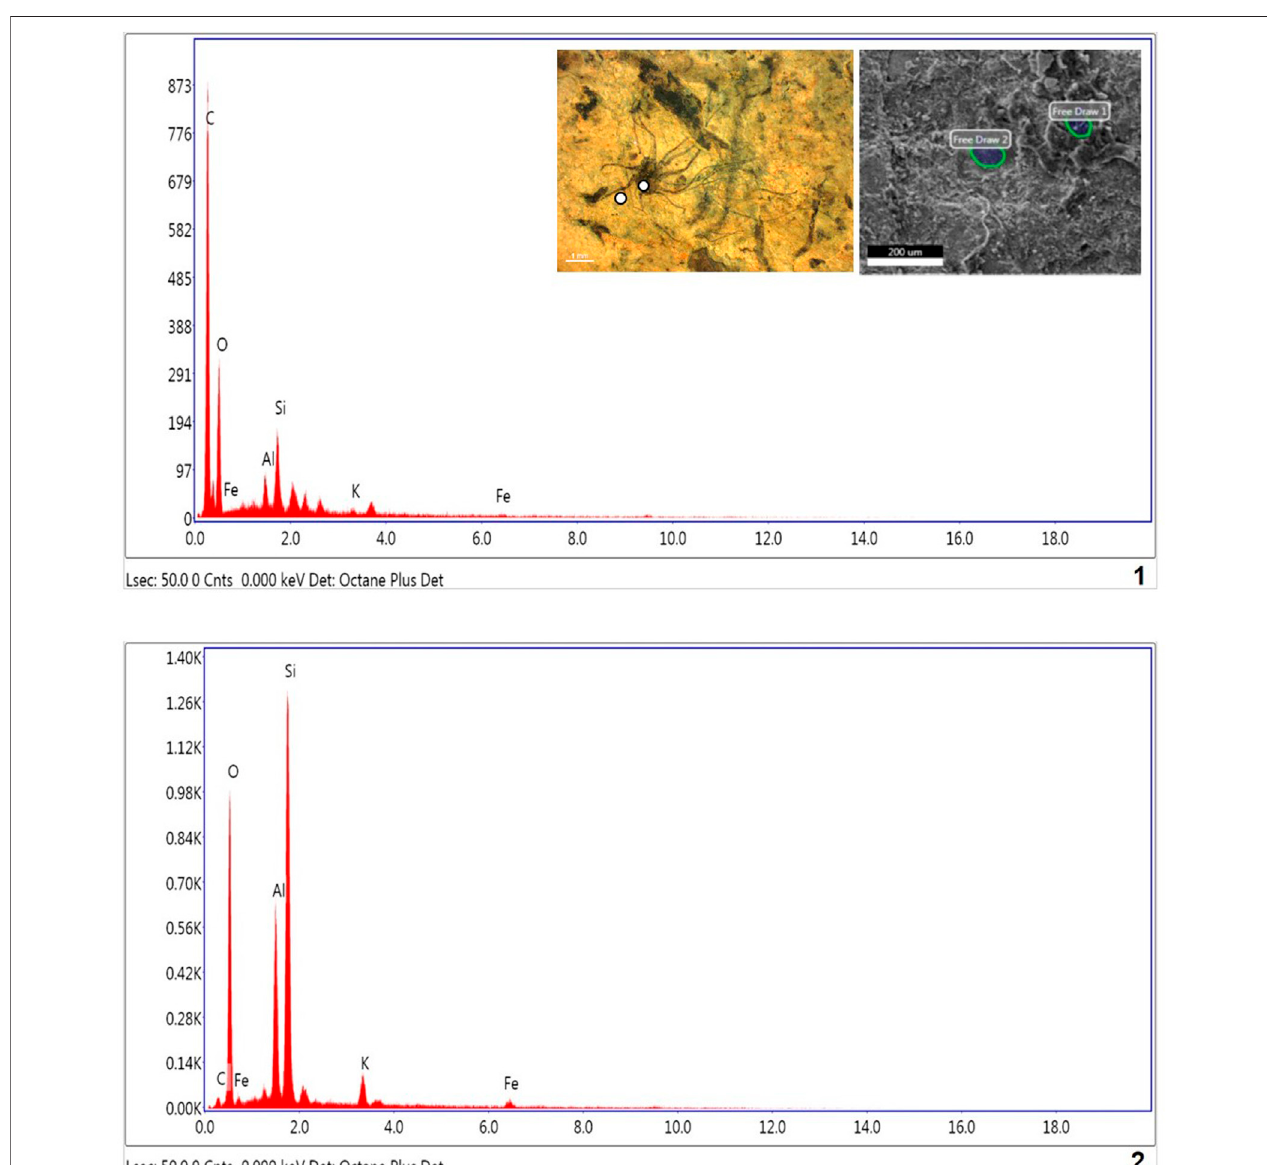
FIGURE 9 | EDX spectra of Singhora carbonaceous compressions and host rock. 1 . Macroscopic fi lm shows high concentration of C and low concentration of other elements respectively. Presence of high carbon in fossils indicated carbonaceous and organic nature of fossils.; 2 . Shale matrix: showing high concentration of Al, SI, O, K, and Fe elements and partial concentration of Si, indicating host rock is aluminosilicate clay.